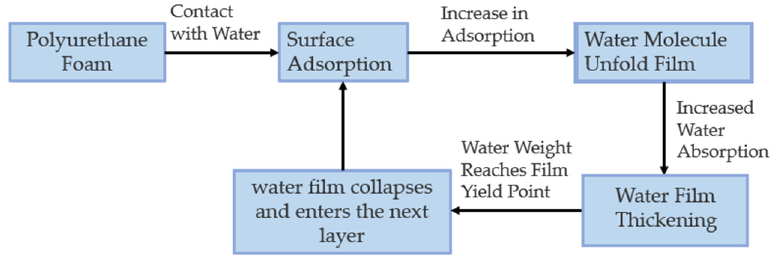
Figure 8. Diffusion process of water in a foam.